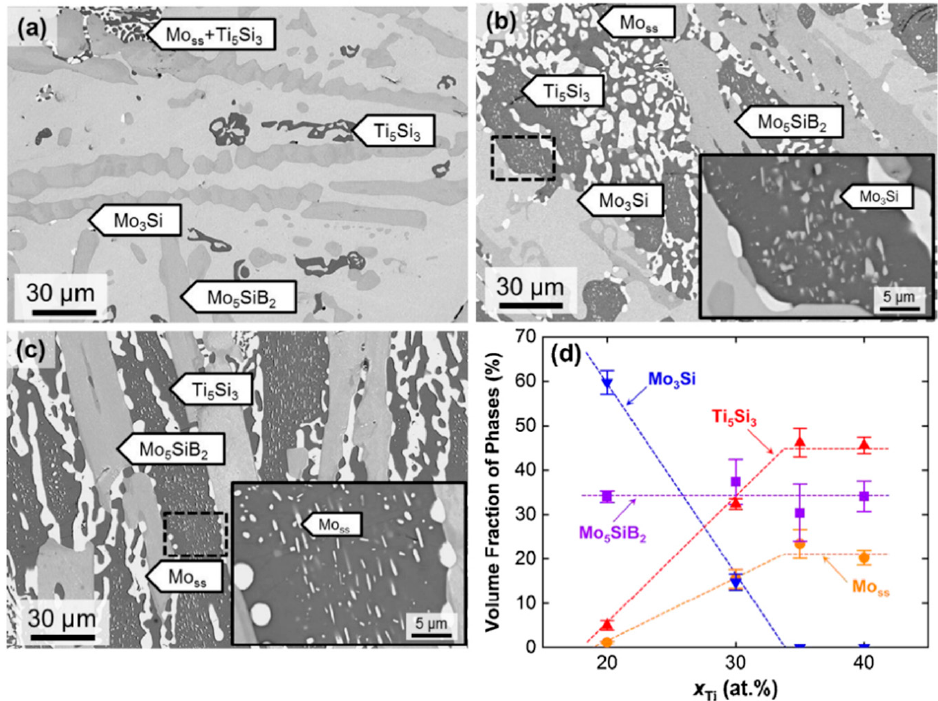
Figure 8. Microstructure of ( a ) Mo–20Ti–20Si–10B, ( b ) Mo–30Ti–20Si–10B and ( c ) Mo–40Ti–20Si– 10B alloys after annealing at 1600 °C for 24 h. The inserts are high-magnification images in dashed squares of the corresponding alloys. ( d ) Experimental measured volume fractions of constituent phases in (70 − x)Mo–xTi–20Si–10B (at.%) alloys (20 ≤ x ≤ 40) [48].